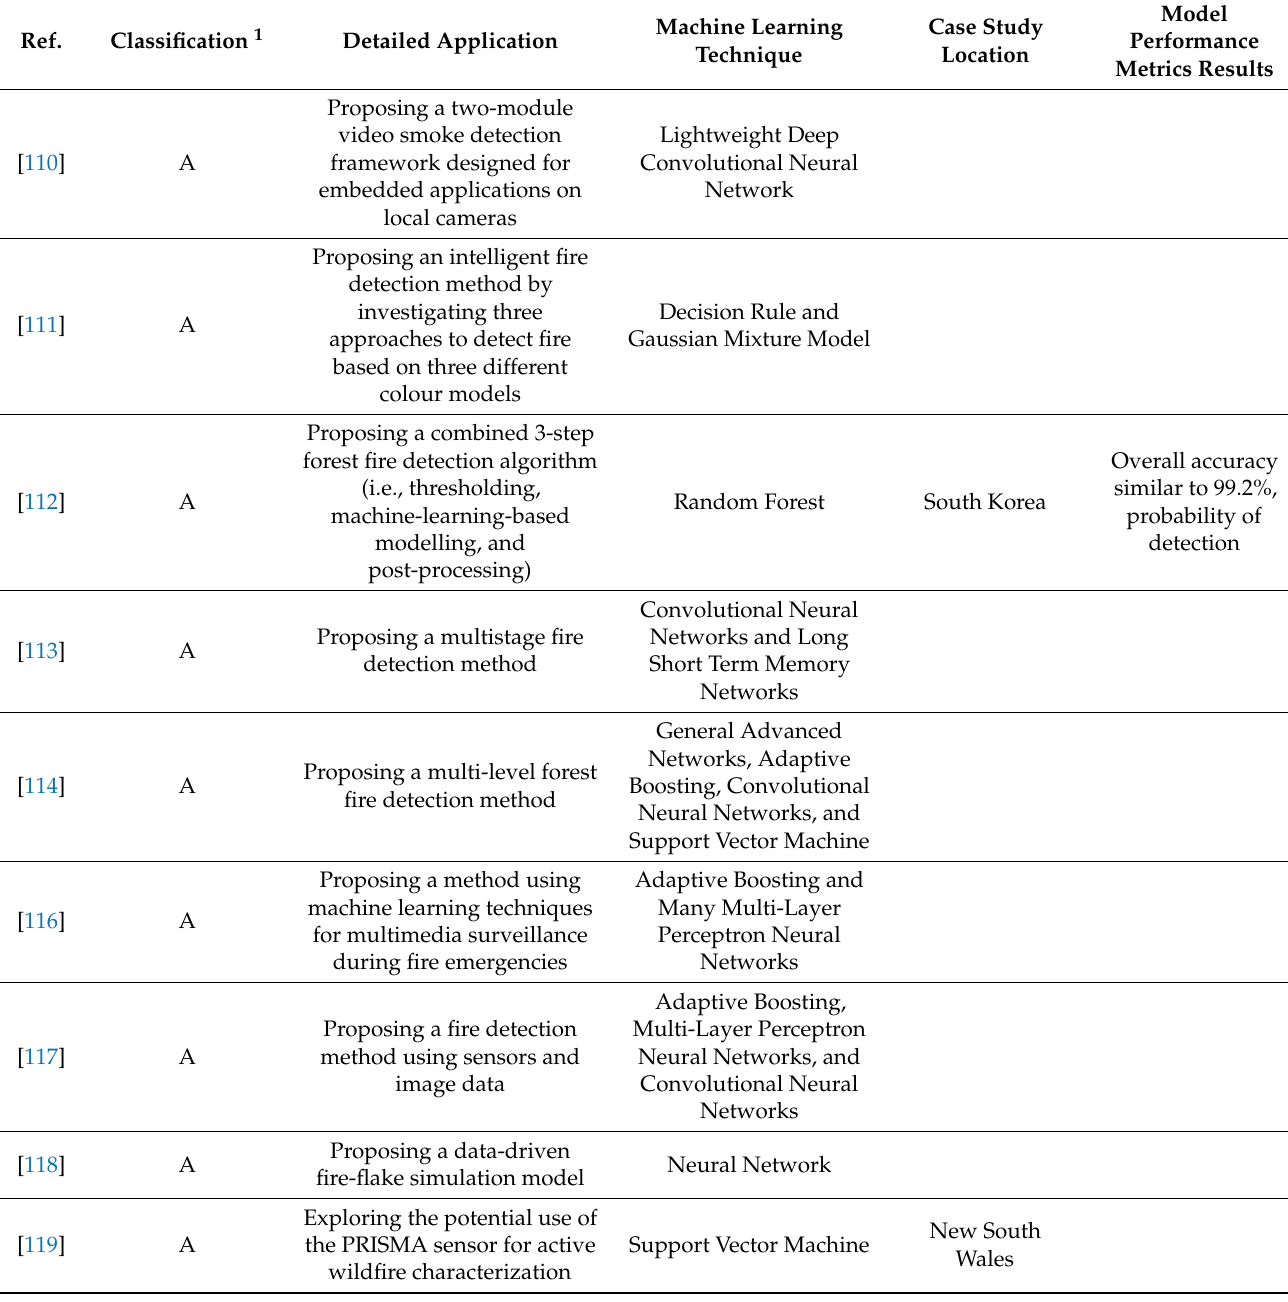
Table 3. Results: management of active wildfire applications.